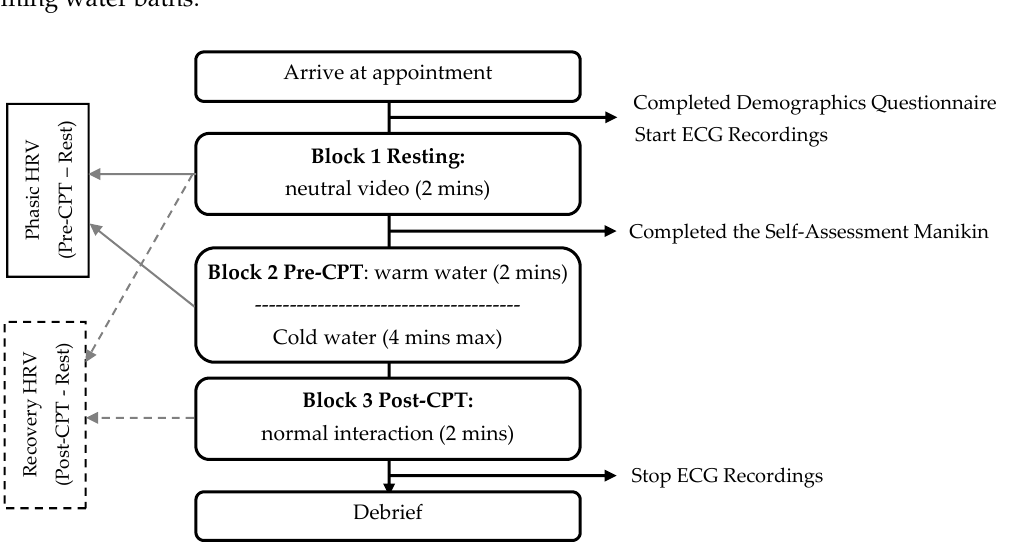
Figure 1 . Timeline of procedure. HRV: heart rate variability; CPT: cold pressor task; ECG: Figure 1. Timeline of procedure. HRV: heart rate variability; CPT: cold pressor task; electrocardiogram. ECG: